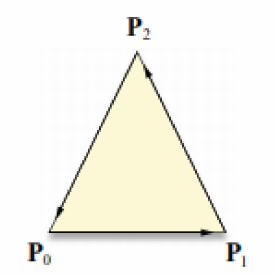
Figure 22. Orientation of a